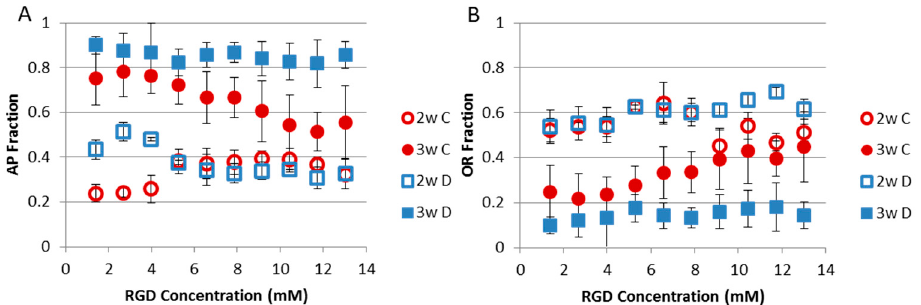
Figure 4. Effect of gradient culture condition on human mesenchymal stem cell lineage selection. ( A ) Fraction of cells expressing alkaline phosphatase, an osteogenic marker; ( B ) Fraction of cells with adipogenic vacuole staining in continuous culture, ( C ) which allows free access to cytokines secreted from cells across the gradient, and discrete culture, ( D ) which limits cytokine access to those secreted from cells in nearly similar RGD concentrations. Adapted and Reprinted with permission from [103].